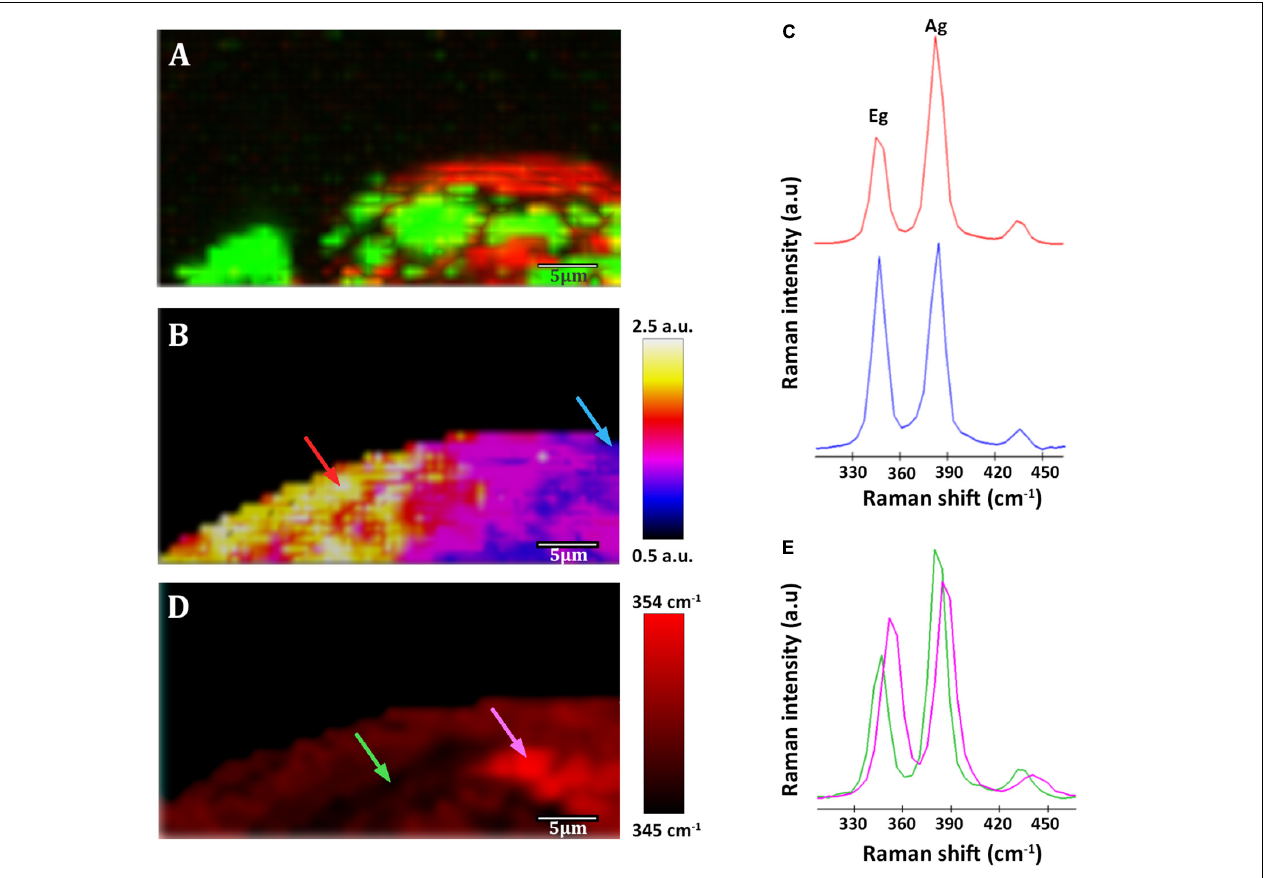
FIGURE 5 | Raman images of a native sample from –228.6 m of the IPB subsurface (see Figure 3 ). (A) Raman map of organic matter. In red, distribution of Acidovorax . In green, distribution of polysaccharides. (B) Raman map colored according to the Ag/Eg ratio intensity of pyrite spectra. (C) Pyrite Raman spectra corresponding to the arrows marked with blue and red color in the image shown in panel (B) . (D) Map showing the Raman shift corresponding to the pyrite Eg band in a color code. (E) Pyrite Raman spectra corresponding to the arrows marked with green and pink in the image shown in panel (D) . Scale bar, 5 µ